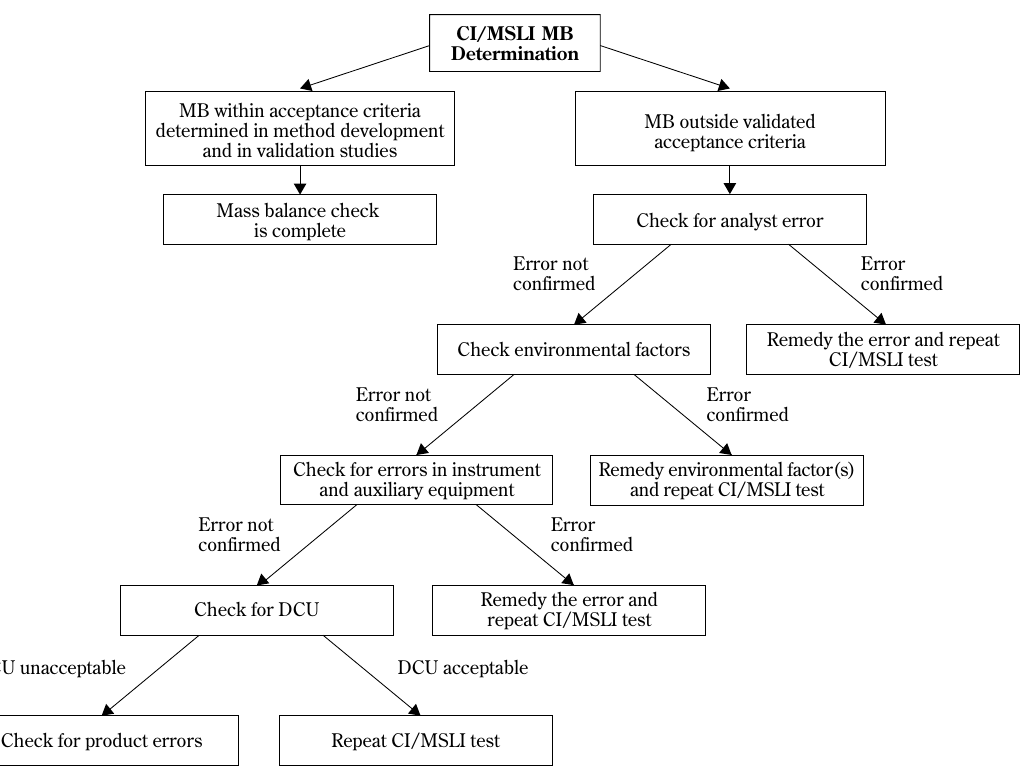
†  Equation 10 was replaced by D 50,1 (cid:2) 12.8 (cid:4) 0.07( Q (cid:4) 60) in order to account for the significant effect of gravity on its operation From [60]: used by permission, Mary Ann